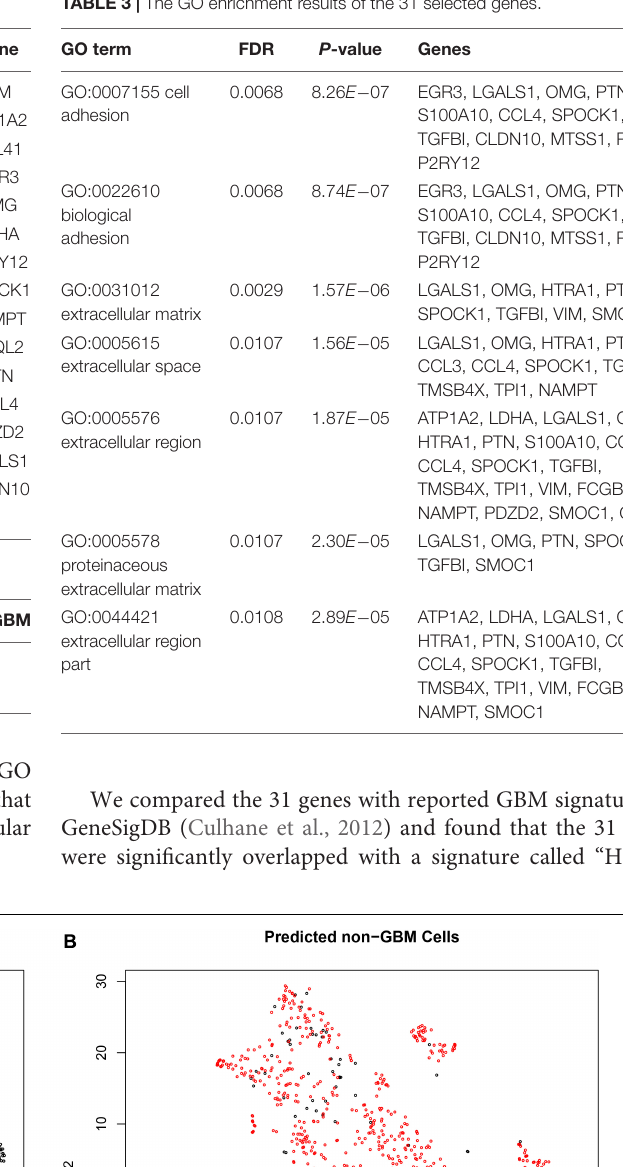
Frontiers in Bioengineering and Biotechnology |